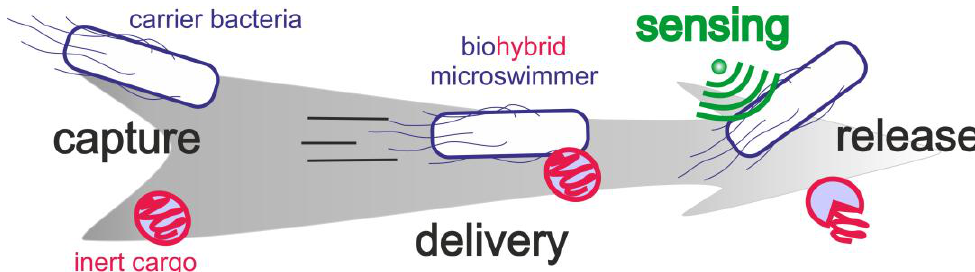
Figure 1. Bacterial biohybrid microswimmers development in a nutshell—capture, delivery, sensing, and release.